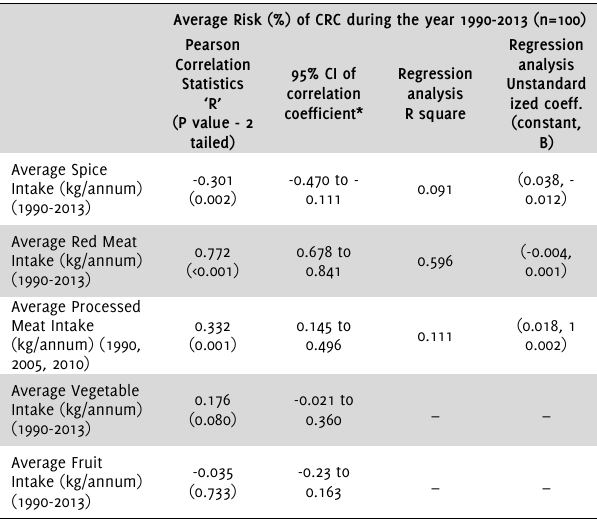
Table 3 . Results of Partial Correlation Analysis.